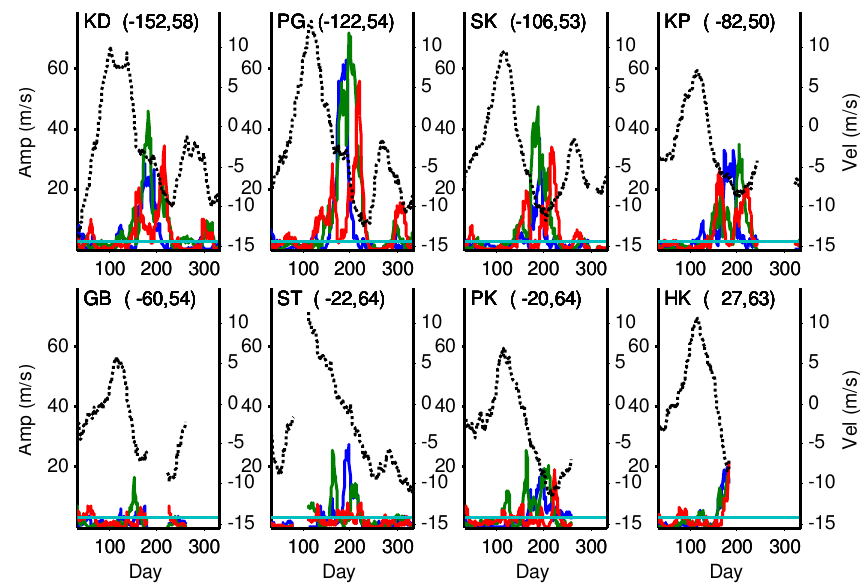
Figure 5. The normalised power spectrum of the meridional 42-h (blue), 48-h (green) and 52-h (red) QTDW components and the zonal mean flow (dotted) for different radars, as indicated by the abbreviations on the top left-hand corner of each panel. The horizontal line represents the 95% confidence level.